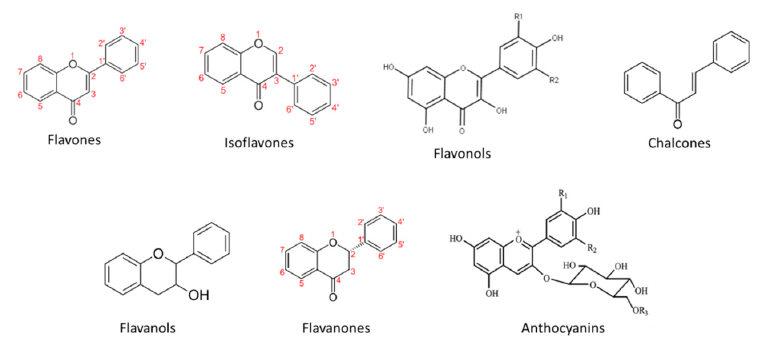
Figure 4. Main flavonoid groups.